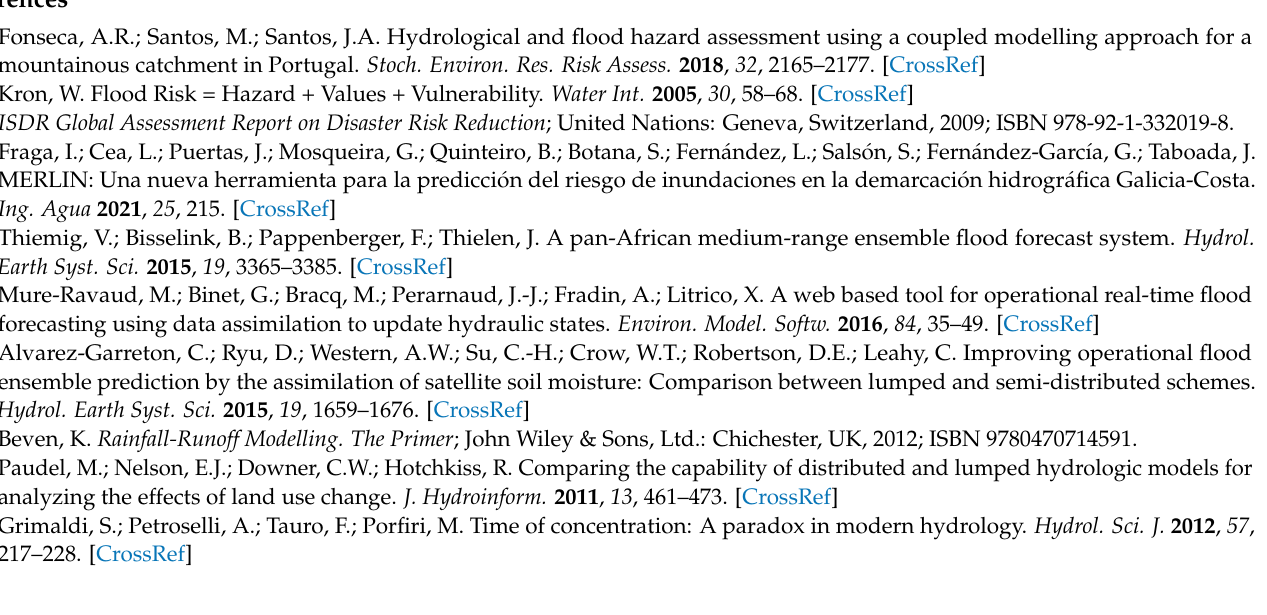
gauges stations (green stars) according to a Thiessen polygon discretization (black lines) and location of the hydrometric station (yellow pentagon); (b) Map of land uses and location of the outlet (red dot), georeferenced in UTM Zone 14N; (c) Map of soil edaphology; and (d) Map of Curve Number according to SCS-CN method, Figure S4: Case study 2. Synthetic hyetographs corresponding to a 50-years return period for the eight most closed rainfall station to Marquelia basin, Figure S5: Case Study 3. Topographical map of the upper part of La Muga basin and location of the gauge station (yellow pentagon) and the outlet (red dot), which is referenced in UTM Zone 31N, Figure S6: Case Study 3. 5-minutal time-resolution hyetographs rainfall intensity (grey bar) and outlet discharge from the reservoir (black line), Table S1: Maximum discharge (in m 3 /s) for the four basins of the Case Study 1 estimated by the Rational Method for a constant rainfall intensity of 25 mm/h, Table S2: Characteristics of the discretization of the Marquelia basin and parameters of the aggregated numerical approach, Table S3: Spatial characteristics of the land uses of the Marquelia basin and Manning roughness coefficient best fit to the 50-years return period synthetic